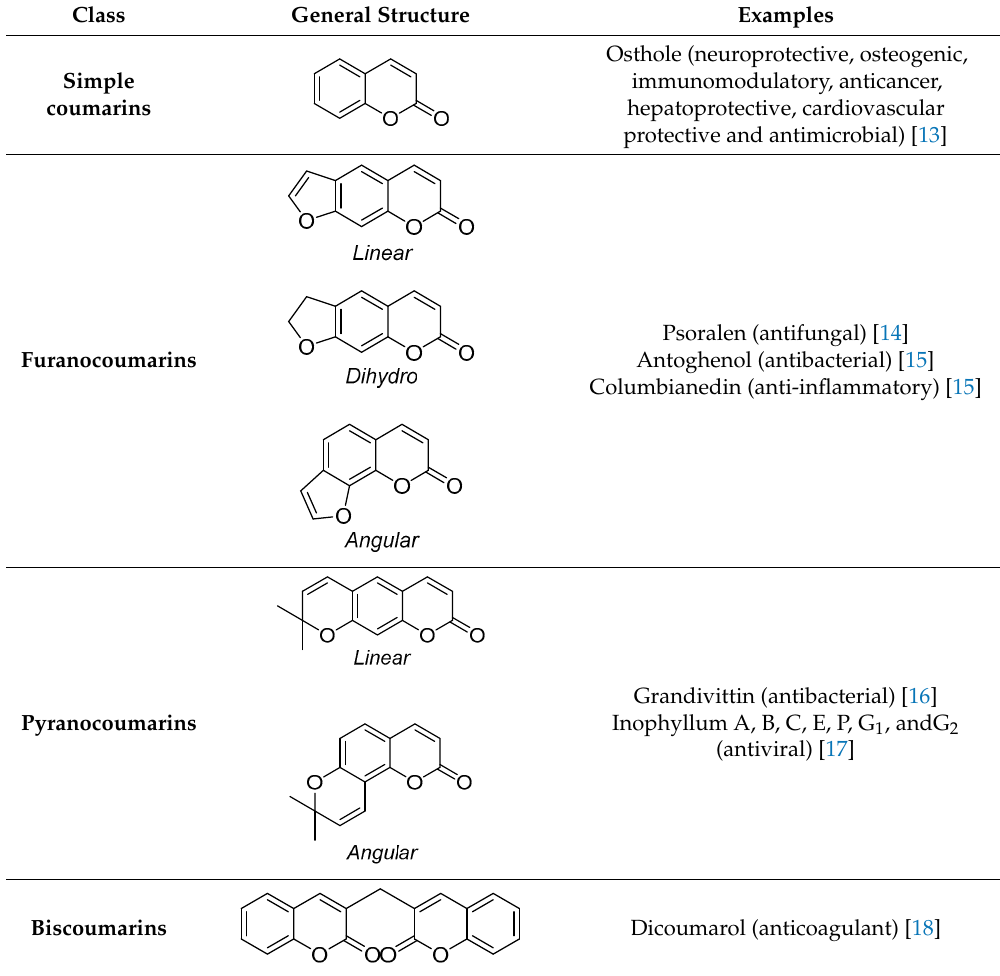
Table 1. Classification of natural coumarins.